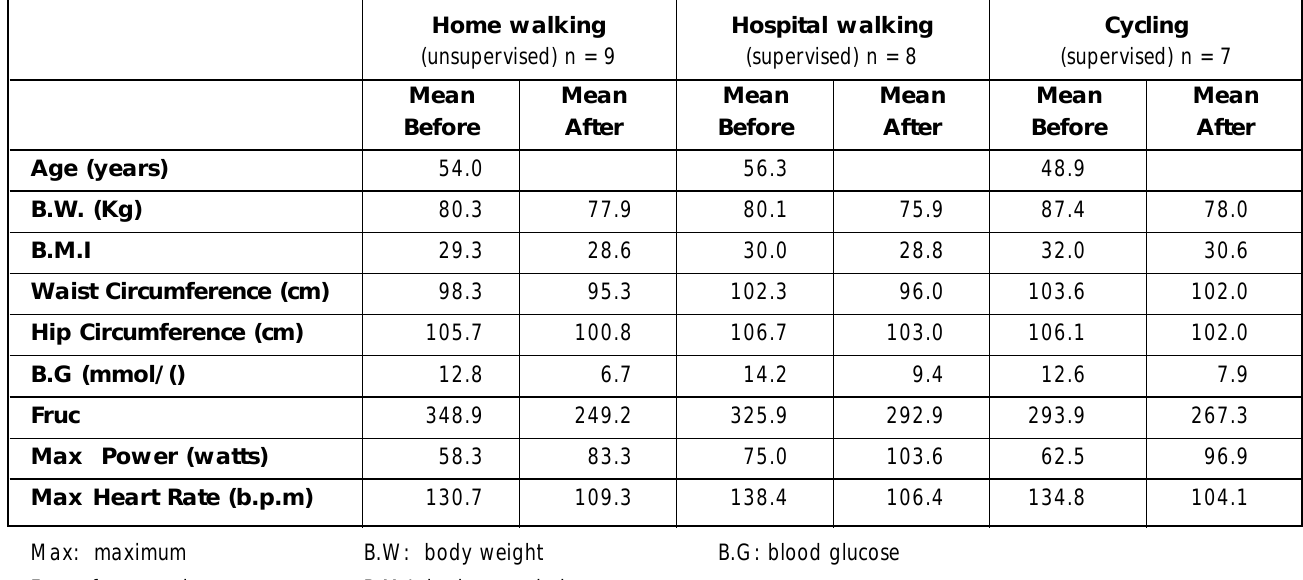
Table 1: Clinical data of all patients (n=24) before and after the exercise